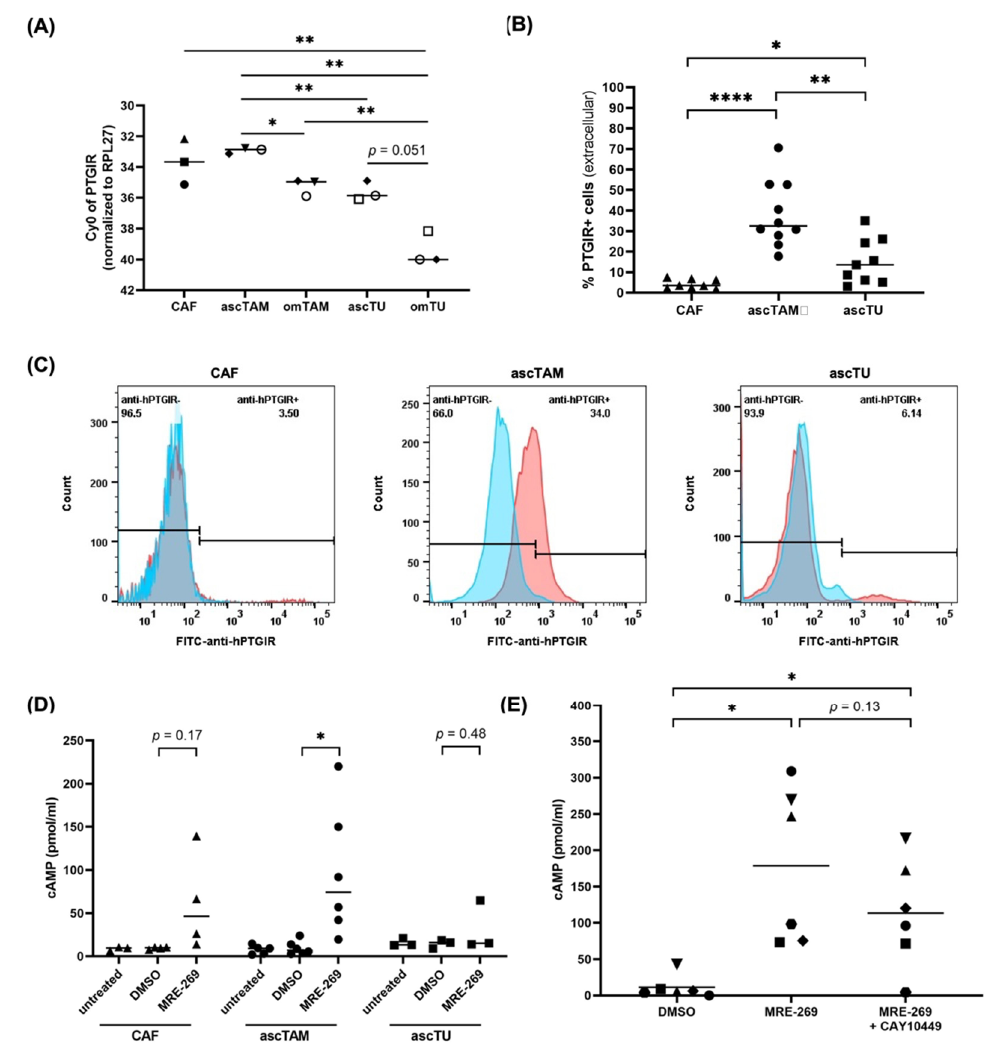
Figure 3. PTGIR expression and signaling in cell types of the HGSC TME. ( A ) RT-qPCR analysis of PTGIS mRNA expression in CAF, TAM (ascTAM, omTAM) and tumor cells (ascTU, omTU) from n = 3 different patients (patients are distinguished by different symbols). * p < 0.05; ** p < 0.01 by unpaired t test (Comparison of different cell types) and paired t test (matched pairs of omental and ascites-derived cells). ( B ) Detection of surface expression of PTGIR by flow cytometry in CAF, ascTAM and ascTU. Percentage of positive cells are indicated. Symbols represent different patients (n = 8 for CAF; n = 10 for ascTAM; n = 9 for ascTU). * p < 0.05; ** p < 0.01, **** p < 0.0001 by unpaired t test. ( C ) Exemplary histograms of PTGIR staining. ( D ) Analysis of intracellular cAMP accumulation upon stimulation of CAF, ascTAM and ascTU with 100 nM MRE-269 for 15 min under serum-free conditions. Untreated cells and solvent-treated cells (DMSO) were included as controls. Symbols represent different patients (n = 4 for CAF; n = 6 for ascTAM; n = 3 for ascTU). * p < 0.05 by paired t test. ( E ) Repression of cAMP accumulation in asc-MDM pretreated with 1 µM PTGIR antagonist CAY10449 (1 h) before stimulation with MRE-269. Symbols represent different patients (n = 6). * p < 0.05 by paired t test. Horizontal bars show the mean.